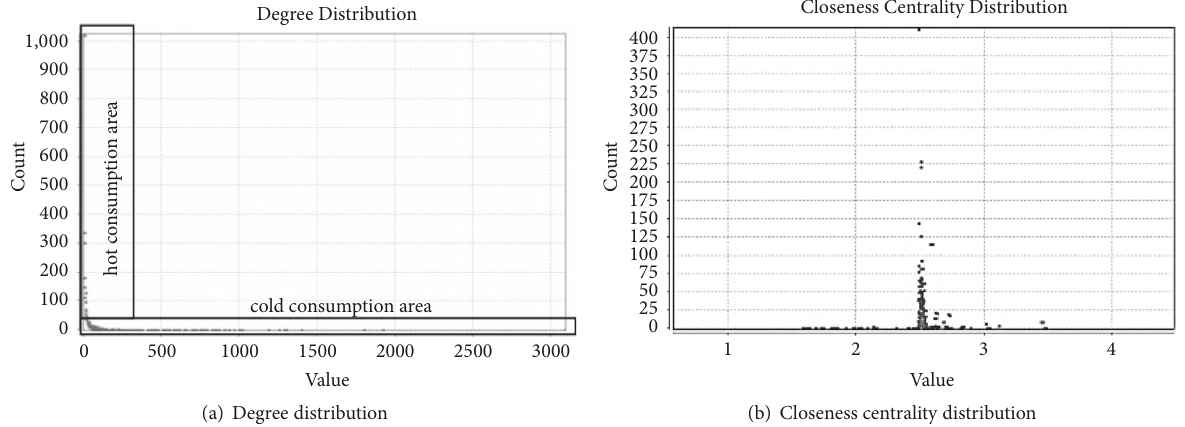
Figure 6: The characteristic distribution of hot consumption and cold consumption